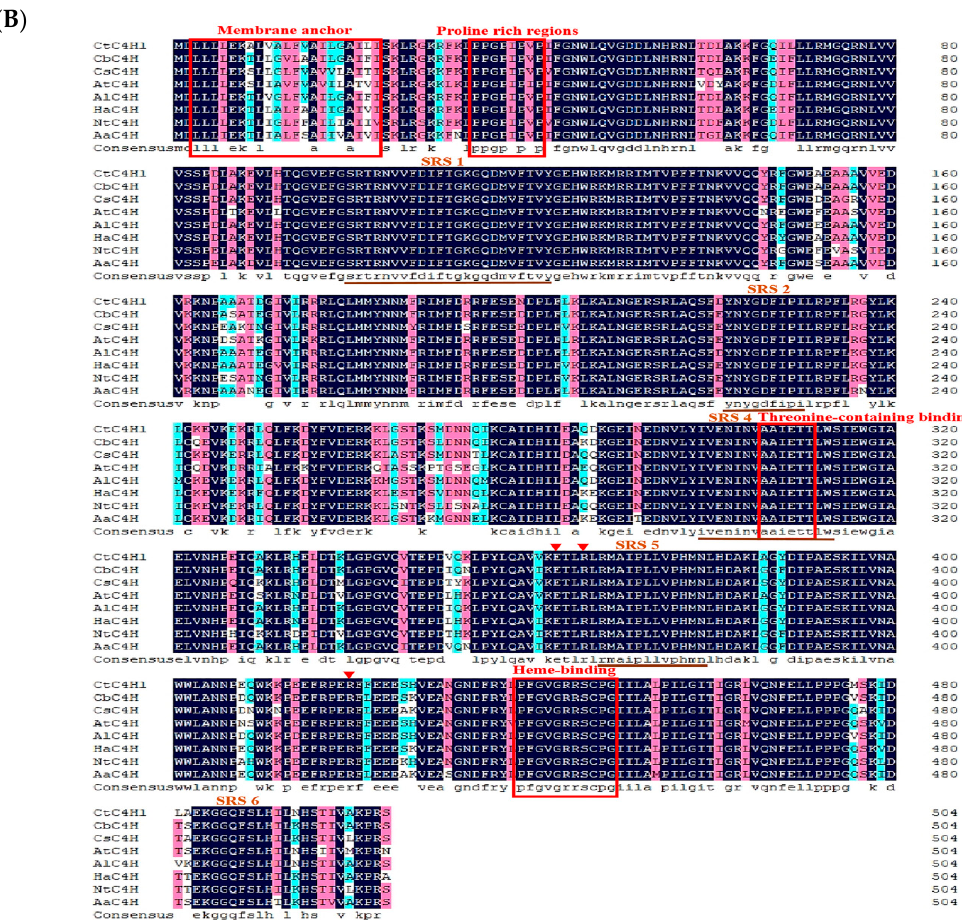
Figure 3. Phylogenetic analysis and multiple sequence alignment of C4Hs proteins ( A ) The phyloge- netic tree containing C4H members from safflower and other plant species. The tree was constructed with MEGA 6.0 using the neighbor-joining (NJ) method and 1000 bootstrap replications. ( B ) Multiple sequence alignment of CtC4H1 and C4H from other plant species. The P450 conserved sequences are boxed in red, the underlined regions represent the six SRSs and Triangle represents E-R-R triad; Cb: Chrysanthemum boreale ; Cs: Camellia sinensis ; At: Arabidopsis thaliana ; Al: Arctium lappa ; Ha: Helianthus annuus ; Nt: Nicotiana tabacum ; Aa: Ageratina adenophora .